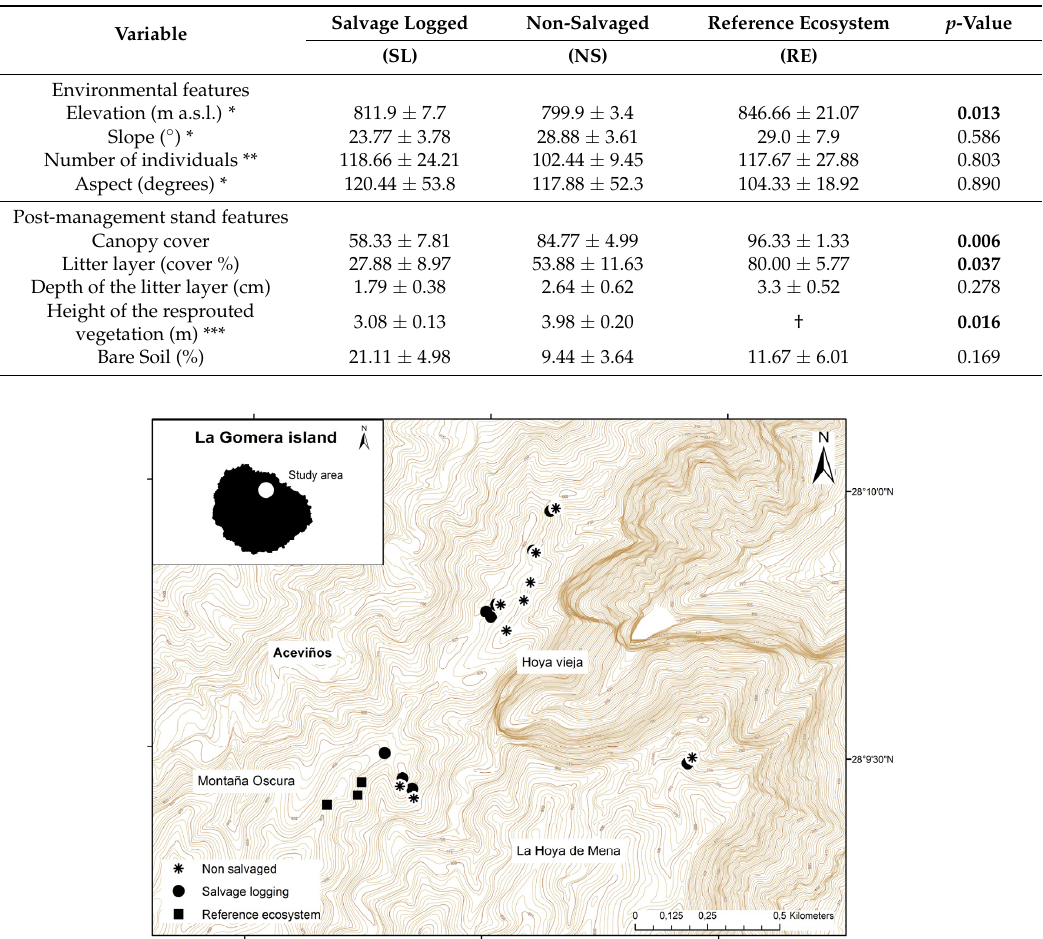
Table 1. Main habitat characteristics in the study plots measured 37 months after the fire (and 22 months after treatment implementation). Values are mean ± SE. p -values calculated after an Analysis of Variance (ANOVA). Bold indicates significant differences among the three treatments. Comparisons among SL and NS alone renders non-significant differences for all the variables except for canopy cover ( p -value = 0.012). (*) Measured at the center of each plot. (**) Number of all trees in the plots